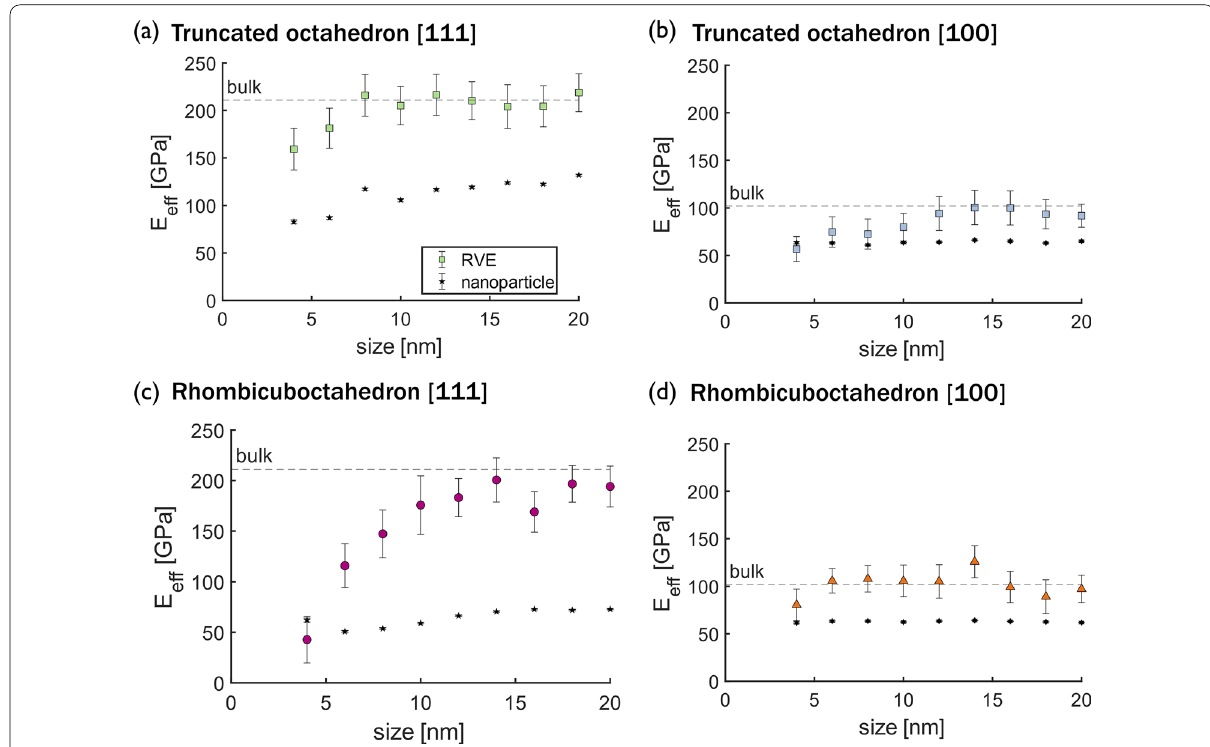
Fig. 5 Effective elastic modulus versus nanoparticle size calculated for an RVE. Size and shape convergence of the effective elastic modulus calculated from the triaxial stress of an RVE at the center of the nanoparticles. Two shapes, ( a , b ) truncated octahedron and ( c , d ) rhombicuboctahedron, were teted in two crystallographic orientations with respect to the direction of the load, ( a , c ) correspond to the {111} orientation and ( b , d ) to the {100} orientation. The bulk values are shown as dashed lines and the effective elastic moduli calculated for the entire nanoparticles from the triaxial state are shown as solid